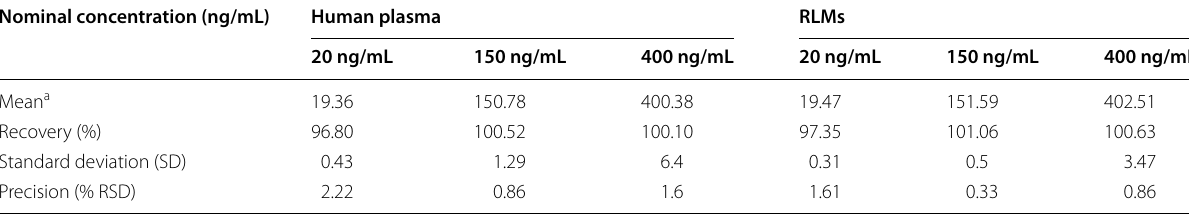
Table 3 Recovery of quality control samples for determining the concentration of VNT in human plasma and RLMs matri-